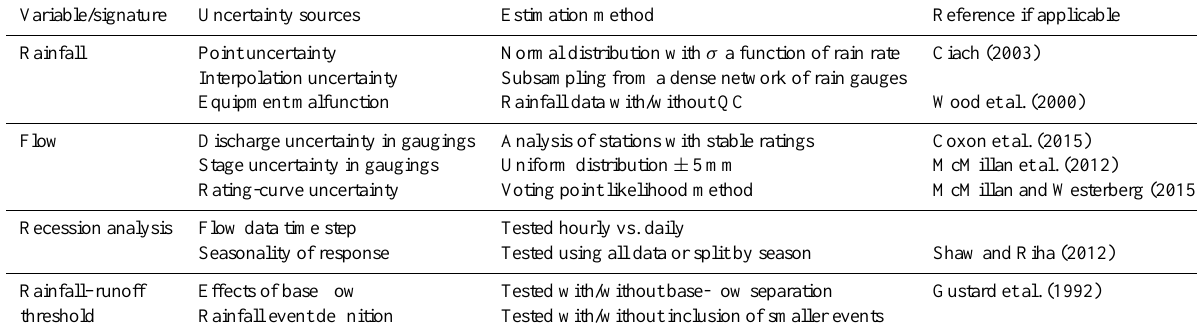
Table 1. Sources of uncertainty considered in this study and the methods used for